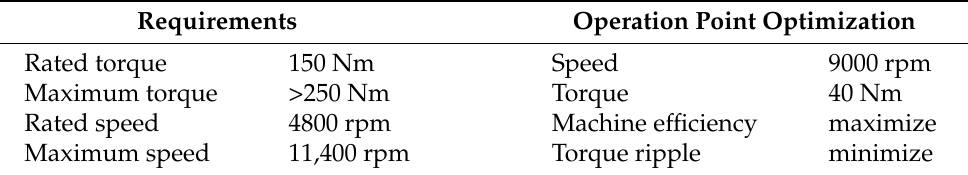
Table 1. Main conditions for